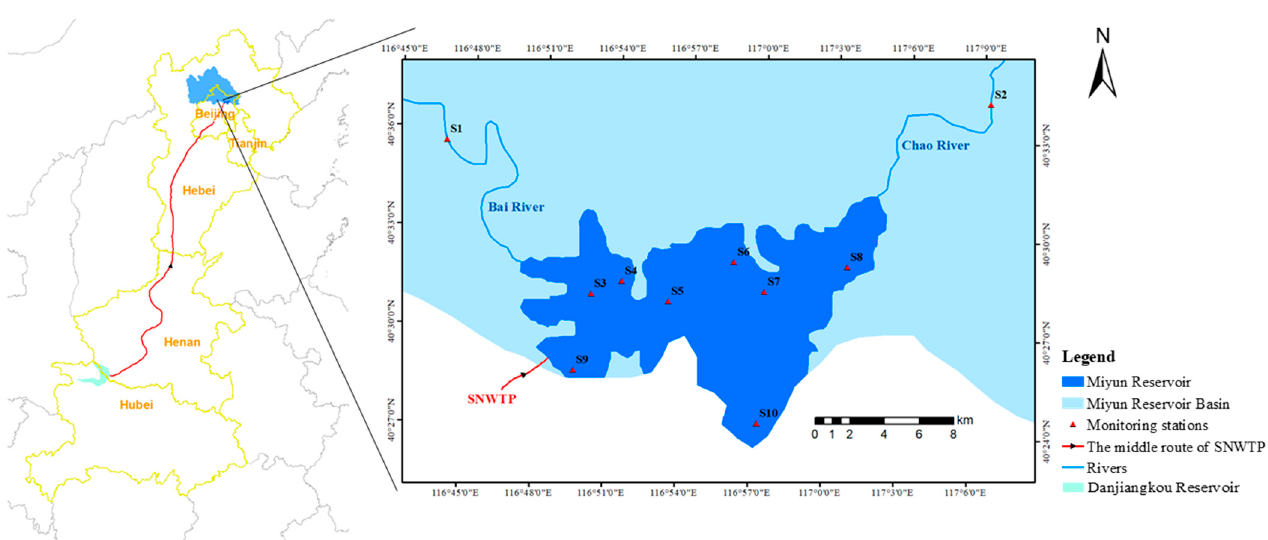
Figure 1. Location of Miyun Reservoir in north China.